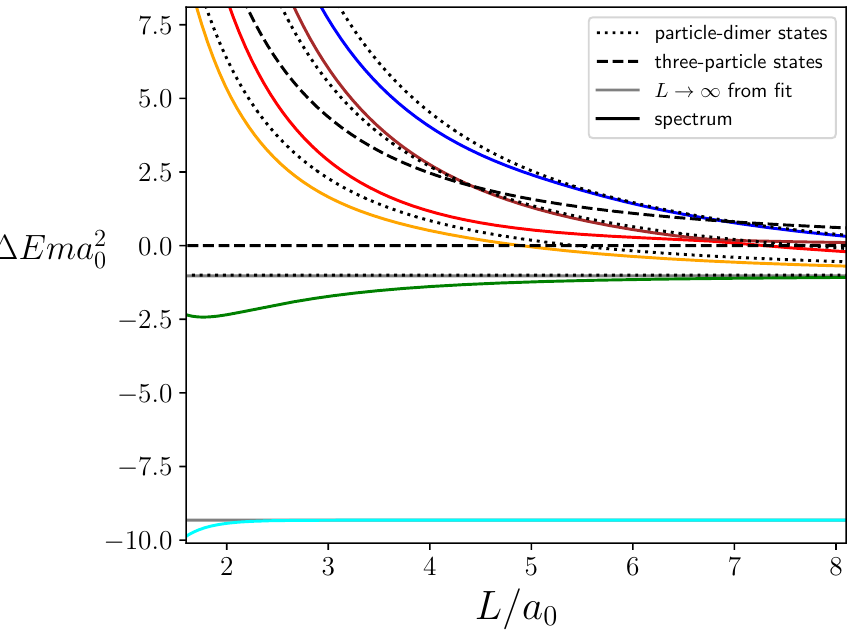
= 0, with (cid:1) E = E (cid:0) 3 m df ; 3